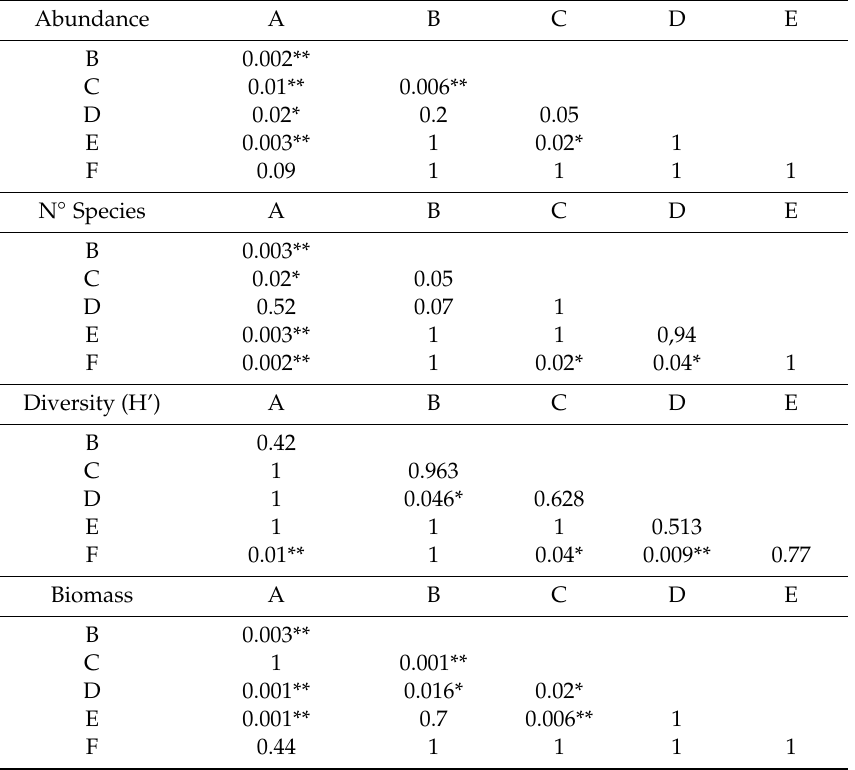
Table 7. Results of post − hoc test between all pairs of sites. (A–F). Significant comparisons at p < 0.05 are marked by * and at p < 0.01 by **. The Bonferroni correction was used.